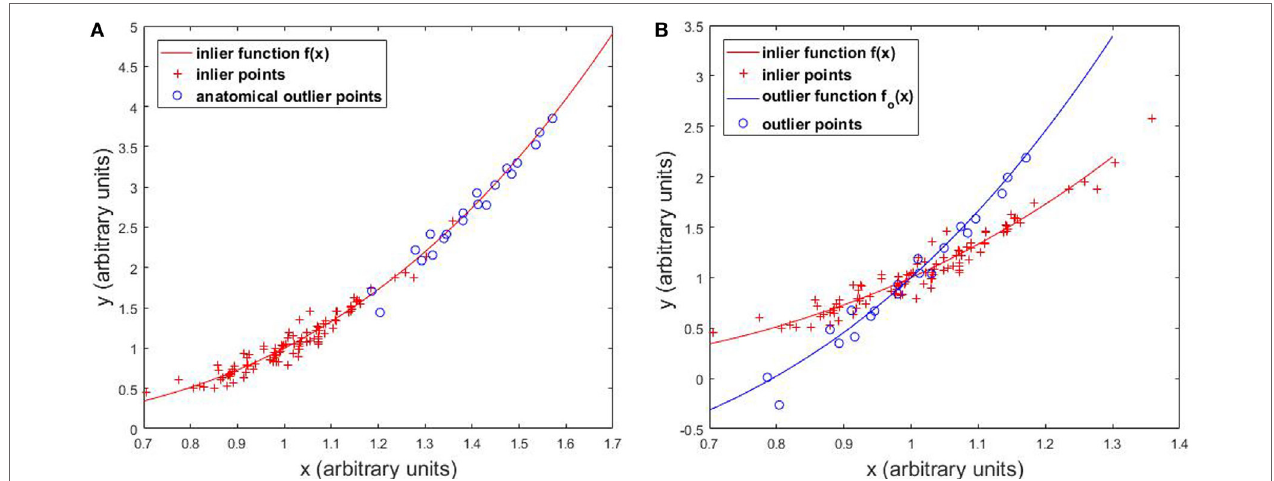
FigUre 2 | Effects of (a) anatomical outliers and (B) dosimetric outliers on the regression model.